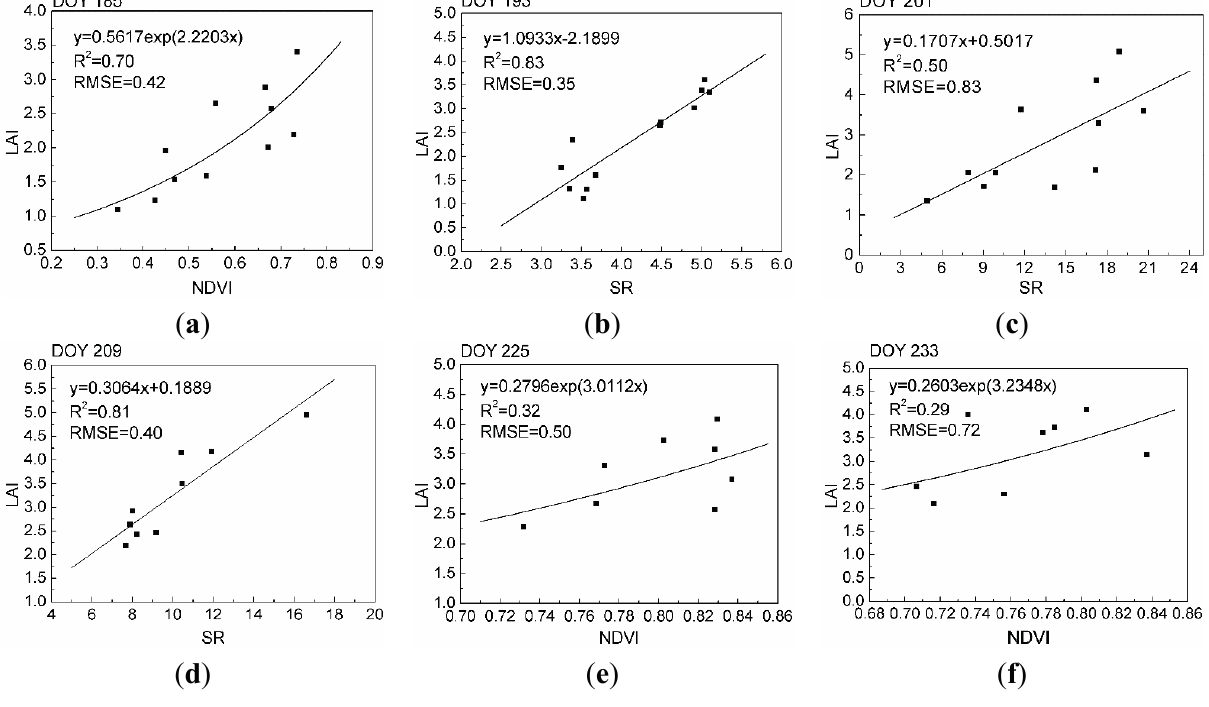
Figure 9. Transfer functions for generating the LAI reference maps at 30-m resolution on